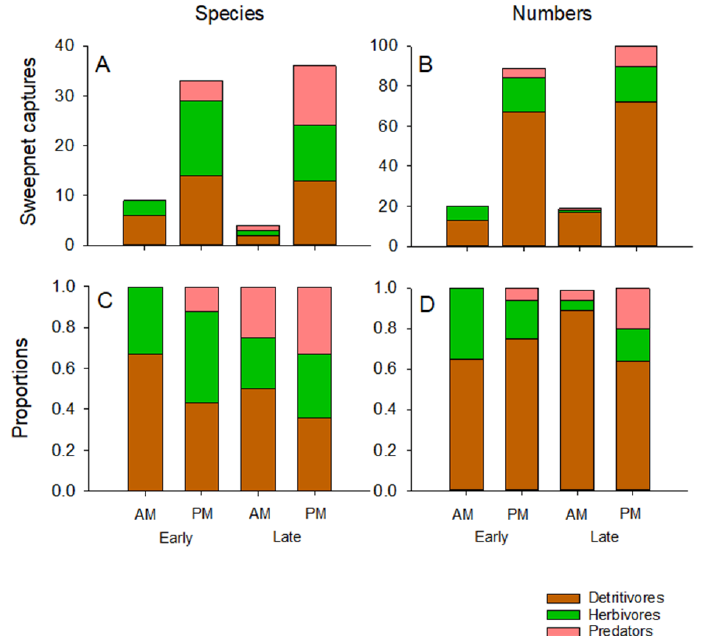
Figure 6. ( A ) Species richness and ( B ) number of individuals representing detritivore (brown), herbivore (green) and predator (red) guilds from sweep net sampling conducted over early stage and